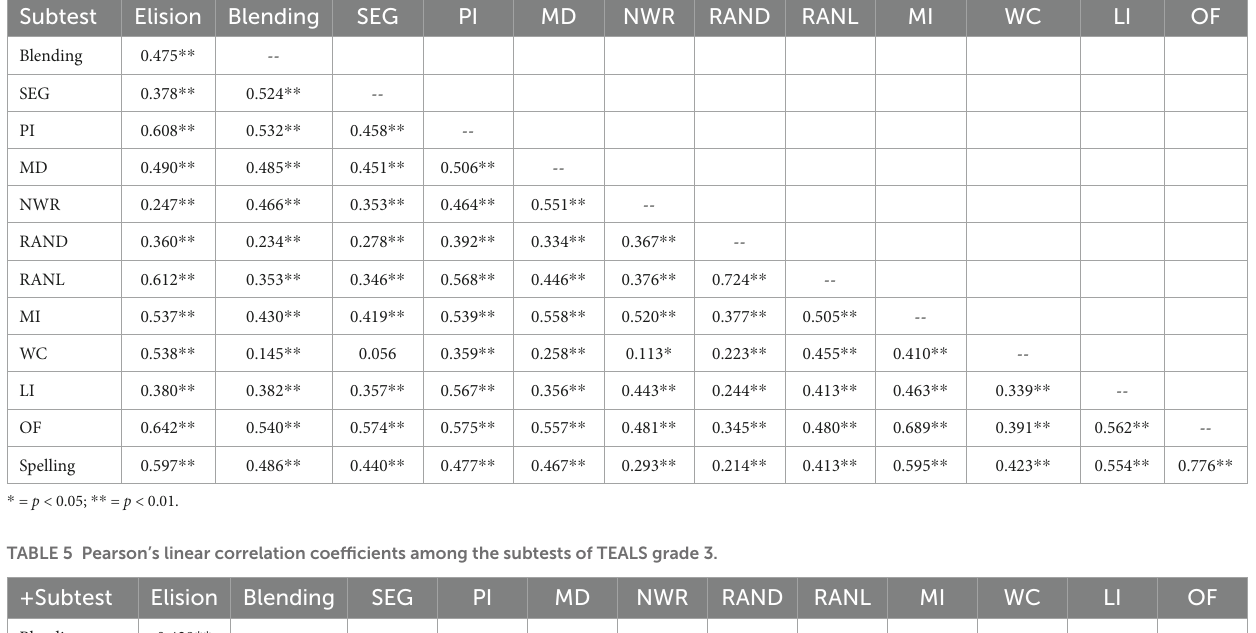
TABLE 4 Pearson’s linear correlation coefficients among the subtests of TEALS grade 2.